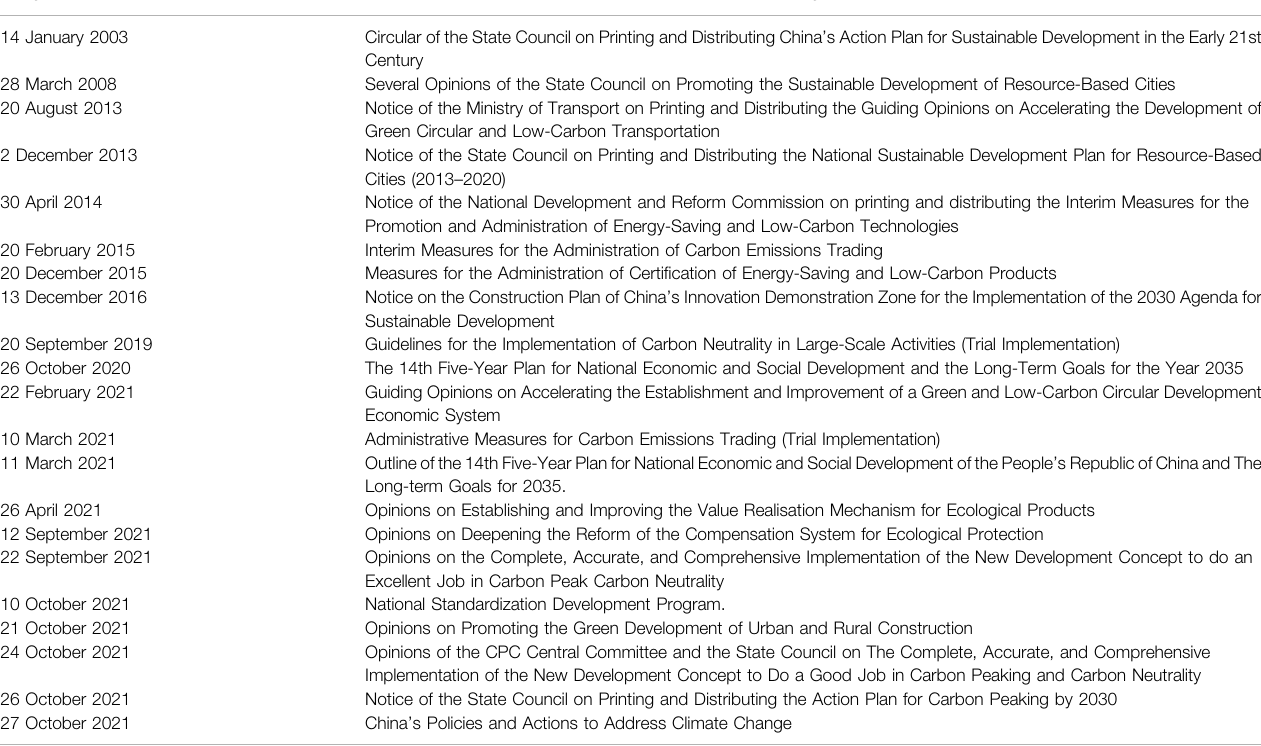
TABLE 1 | Carbon neutrality strategic plans in China from 2003 to